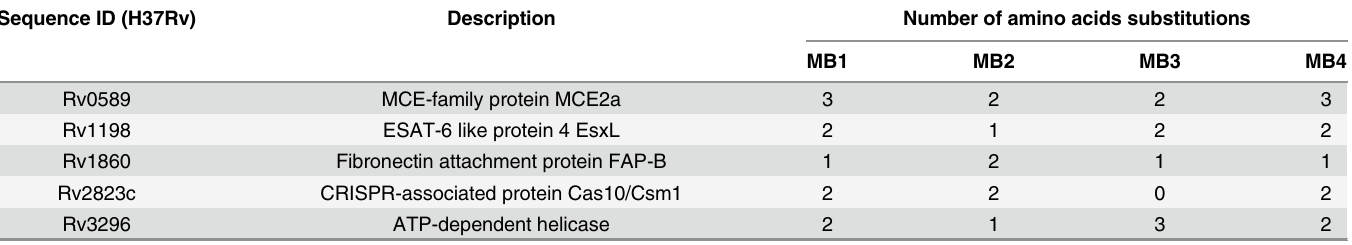
Protein sequence diversity among all isolates was determined in comparison to M . tuberculosis H37Rv. Antigens selected showed an average amino acid diversity >